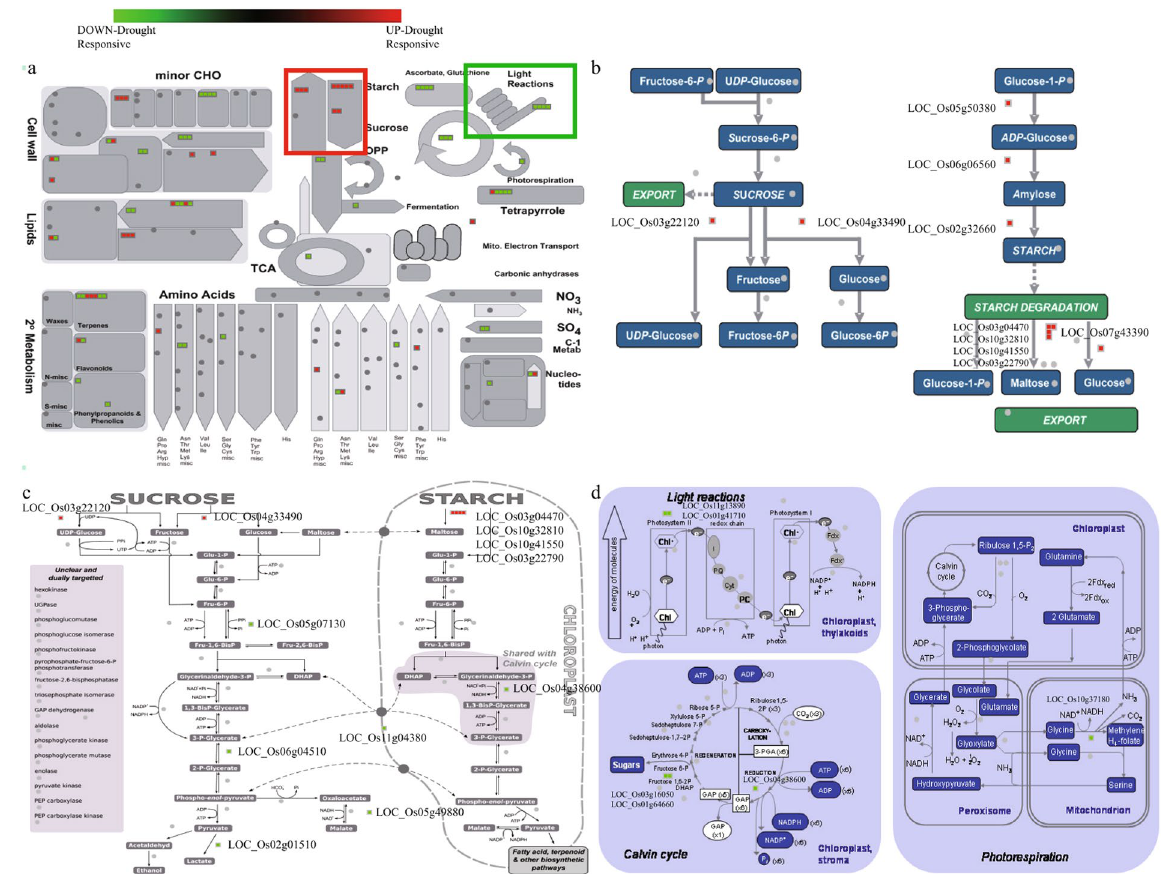
Figure 4. MapMan analysis of drought-responsive genes showing diurnal rhythm. Results of mapping 766 genes to Metabolism overview ( a ), Sucrose-Starch overview ( b ), Plant Glycolysis overview ( c ), and Photosynthesis overview ( d ). Red boxes, genes up-regulated under drought; green boxes, genes down-regulated under drought. Within Metabolism overview, red and green lines indicate MapMan functional groups selected for physiological